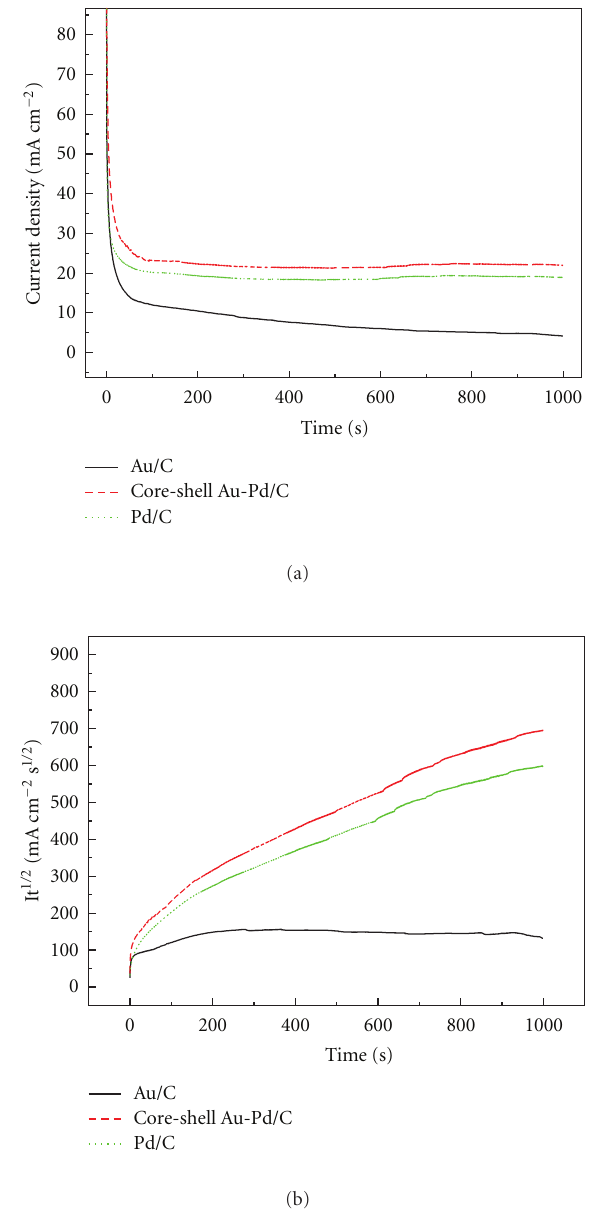
Figure 7: (a) Chronoamperometry curves of BH 4 − oxidation on di ff erent anode catalysts and (b) Cottrell’s plot generated from the chronoamperometry